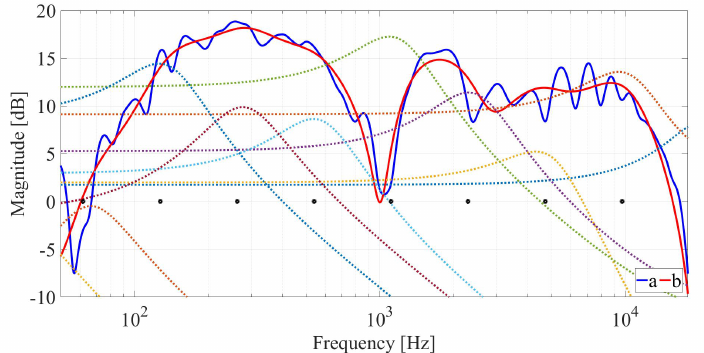
Figure 7. Bank’s parallel filter design example: ( a ) RTF; ( b ) the resulting filter frequency response. The dotted lines represent the individual transfer functions of the 16 second-order sections, while the circles display the pole